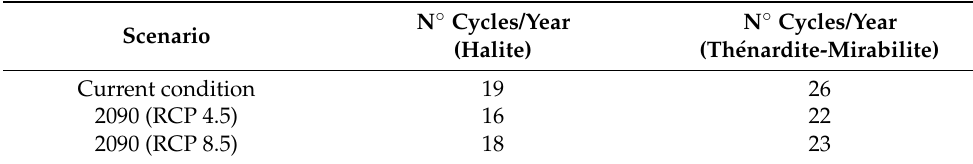
Table 10. Deliquescence-crystallization cycles (Halite) and phase transitions (Thénardite to Mirabilite) of the two salts analysed for the different climate scenarios.